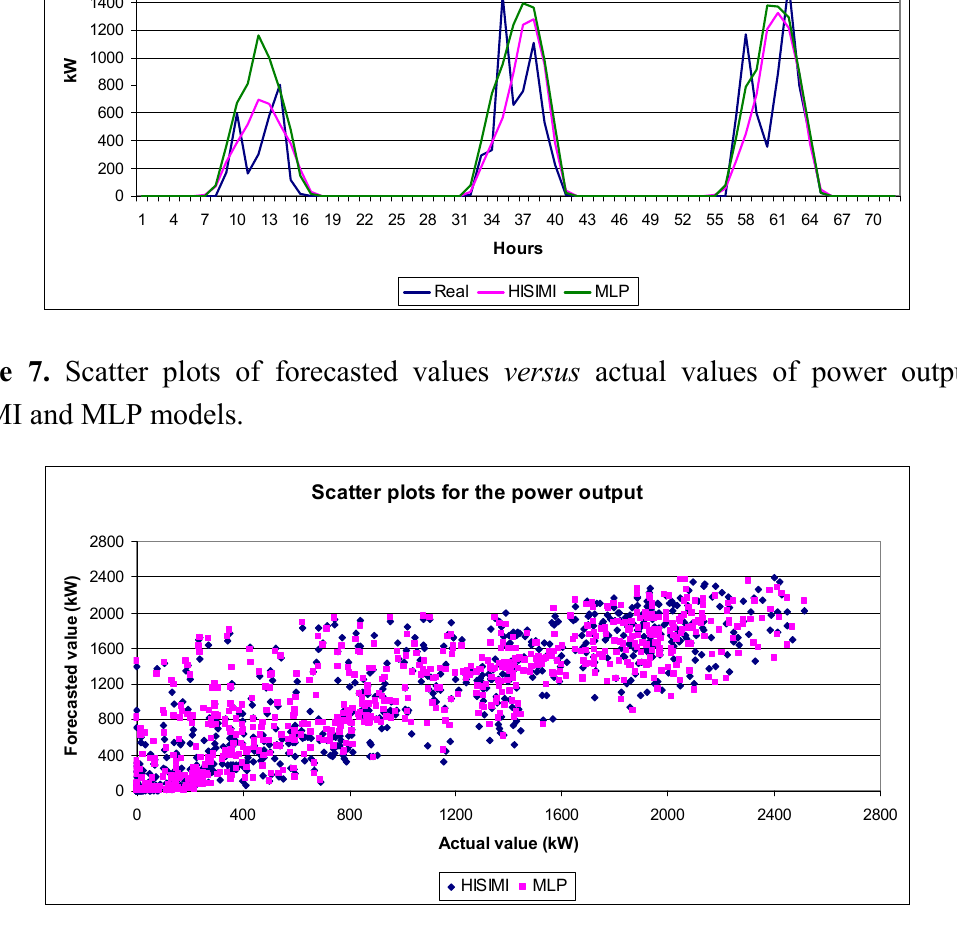
Figure 8. Histograms of absolute errors for the HISIMI and MLP models in the testing data